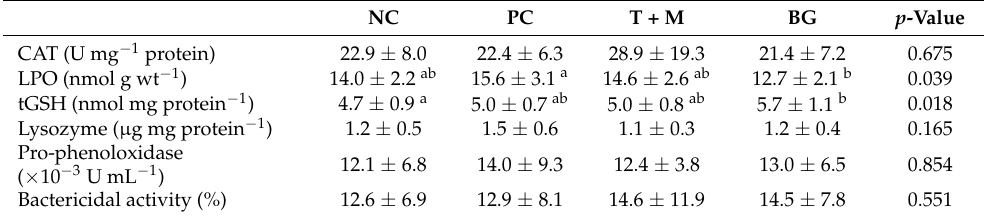
Table 5. Catalase (CAT), lipid peroxidation (LPO), total glutathione (tGSH), lysozyme, pro- phenoloxidase, and bactericidal activity levels in whiteleg shrimp ( P. vannamei ) PL fed the experimen- tal diets for 18